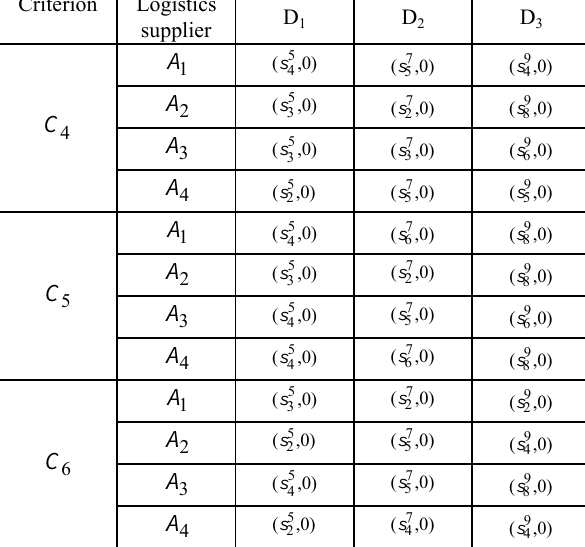
Table 8. The rating linguistic variable by